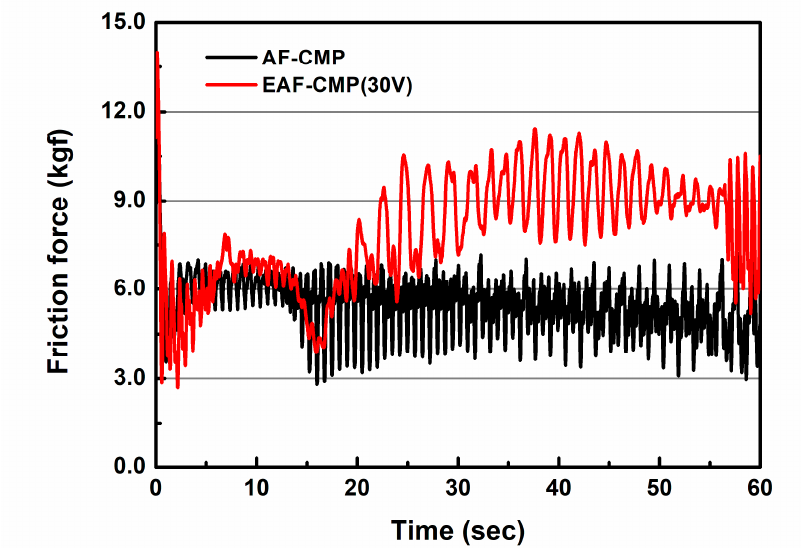
Figure 7. Friction force as a function of processing time in AF-CMP and EAF-CMP. Table 2. Comparison between AF-CMP and EAF-CMP.